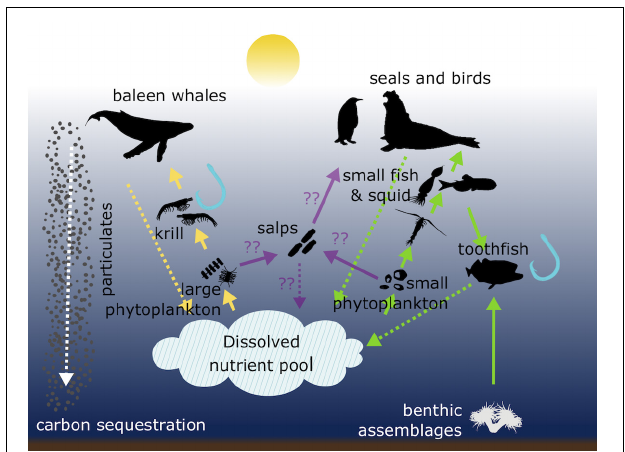
FIGURE 10 | Major biological energy pathways by which energy moves from primary producers to higher trophic levels in Southern Ocean ecosystems (integrated across seasons and across open water and sea-ice environments). These pathways include the well-studied Krill food-chain (yellow), as well as less well-studied pathways via small fish and squid (green), and potentially salps (purple). The relative dominance of these pathways underpins ecosystem structure and function and the provision of services such as fisheries (blue hooks) and carbon sequestration (white dotted arrow). However, these pathways and the factors that determine their relative dominance in space and time are not well resolved. Targeted observing effort will be required to fill this knowledge